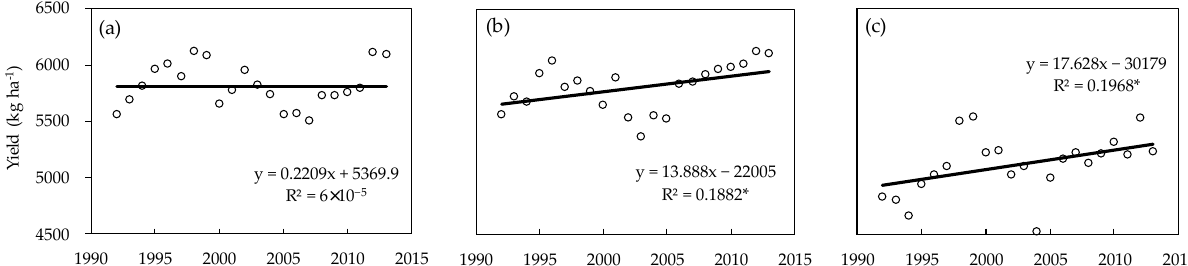
Figure 4. Trends in the yield of early rice in the three climatic zones. ( a , b , c ) indicate the northern subtropical zone (NST), middle subtropical zone (MST) and south subtropical zone (SST), respectively. ** Significant at p < 0.01.